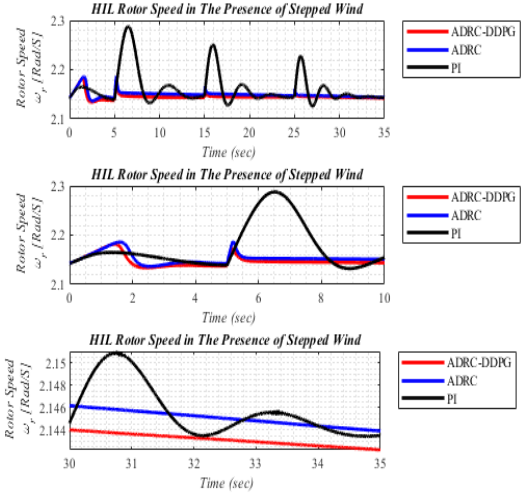
Figure 10. HIL output comparative results of active disturbance rejection controller-deep deterministic policy gradient (ADRC-DDPG), active disturbance rejection controller (ADRC) and PI controllers according to the scenario I.